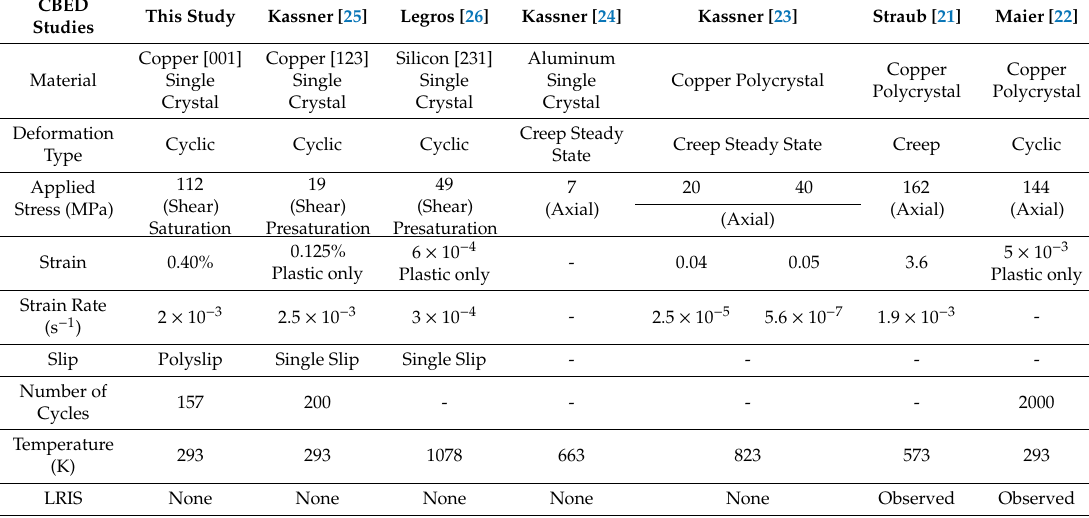
Table 1. Summary of studies on creep and cyclically deformed materials that utilized CBED to assess long range internal